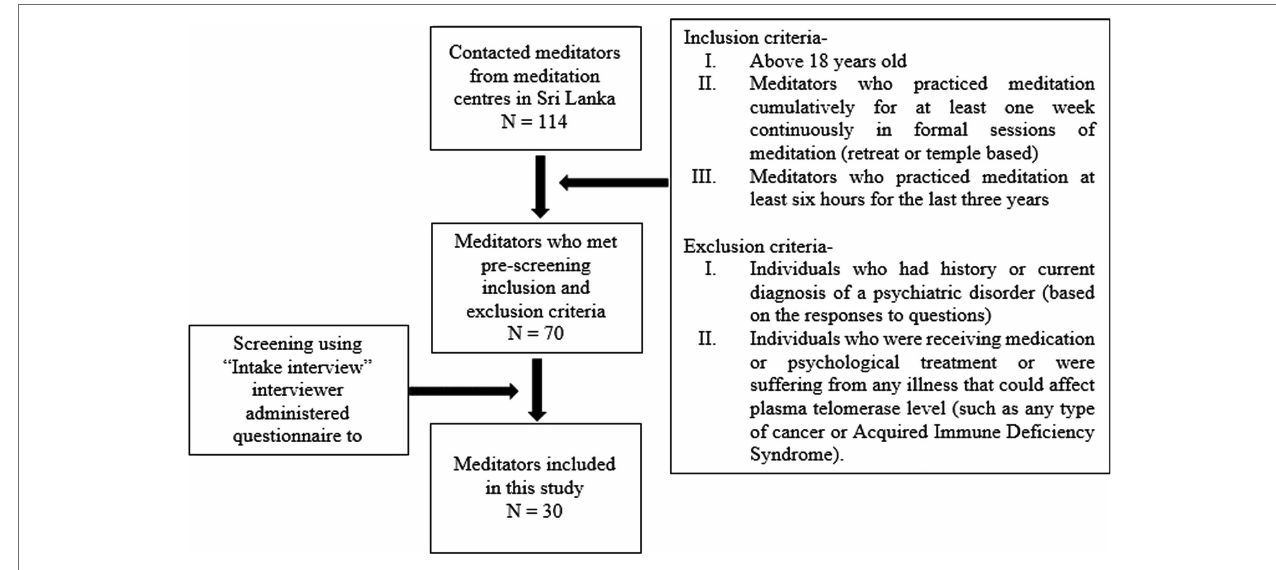
FIGURE 2 | The process of recruiting skilled meditators to the